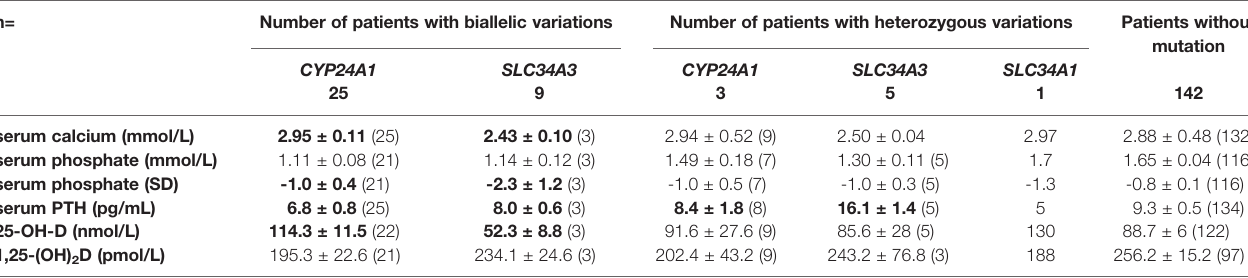
TABLE 3 | Biochemical data according to